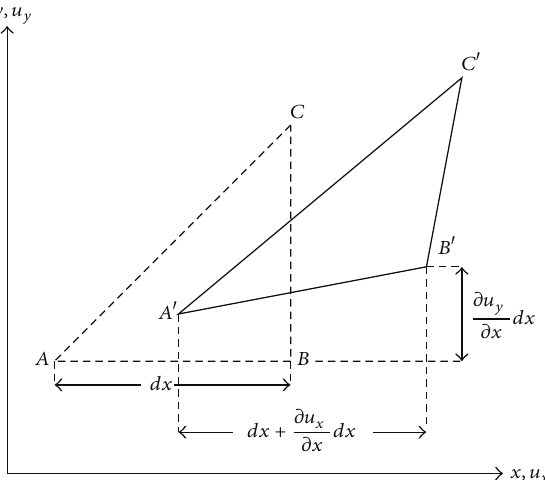
Figure 1: 2D element before and after